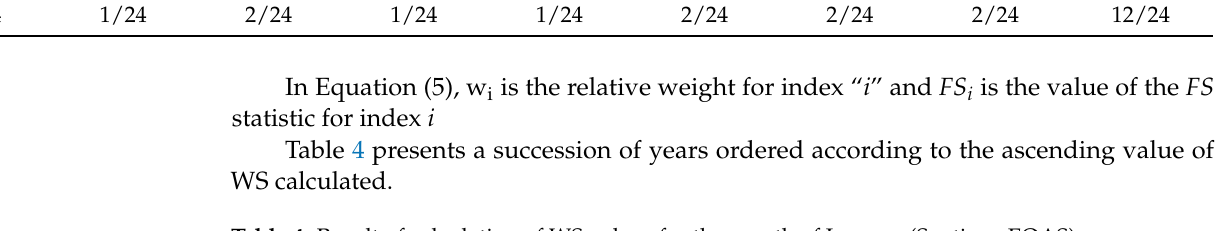
Table 4. Result of calculation of WS values for the month of January (Santiago